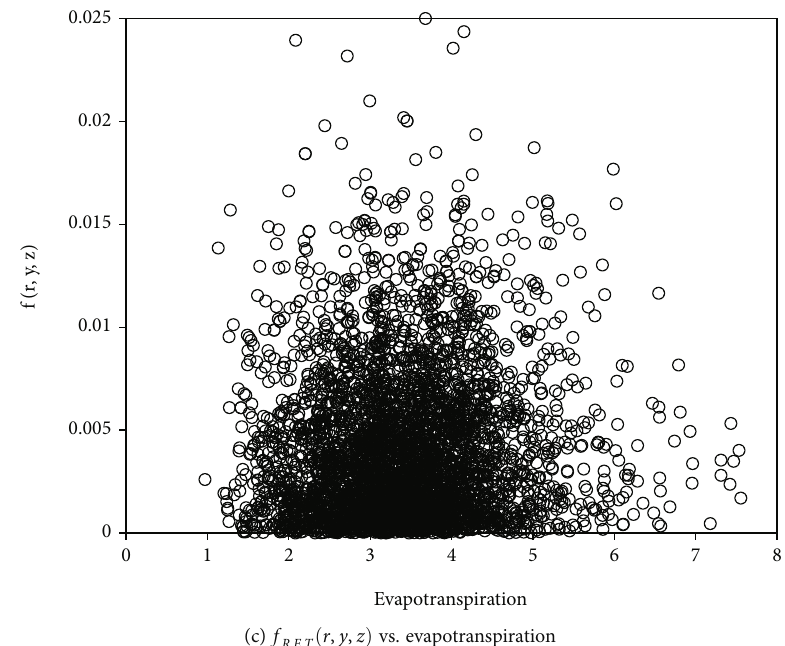
r , y , z Þ estimated from Plackett Figure 8: f R , E , T ð